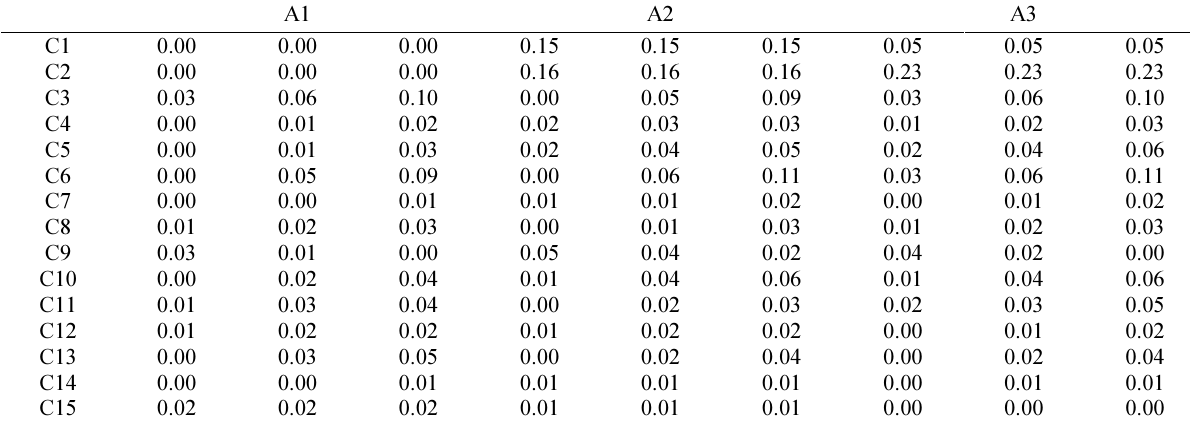
Table 8. Weighted decision